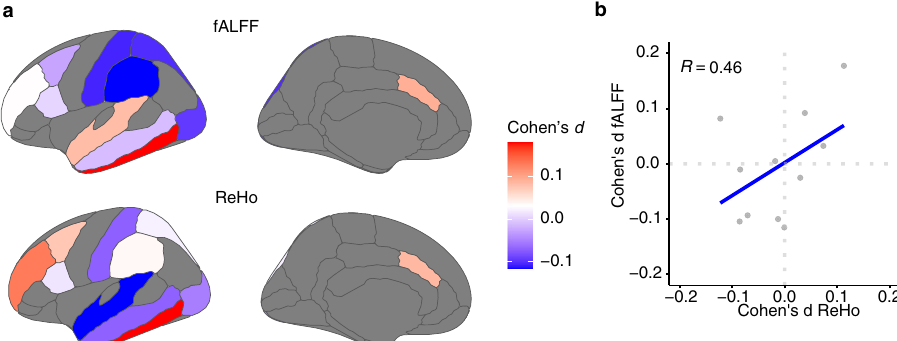
Fig. 2 Imaging differences between ASD and CTL. a Differences between ASD and CTL calculated by Cohen ’ s d (effect sizes) derived from ASD – CTL comparison for both rs-fMRI measurements across the ROIs analyzed. b Scatter plot depicting the spatial correlation between Cohen ’ s d values of fALFF and ReHo. Each dot corresponds to the ROI analyzed.